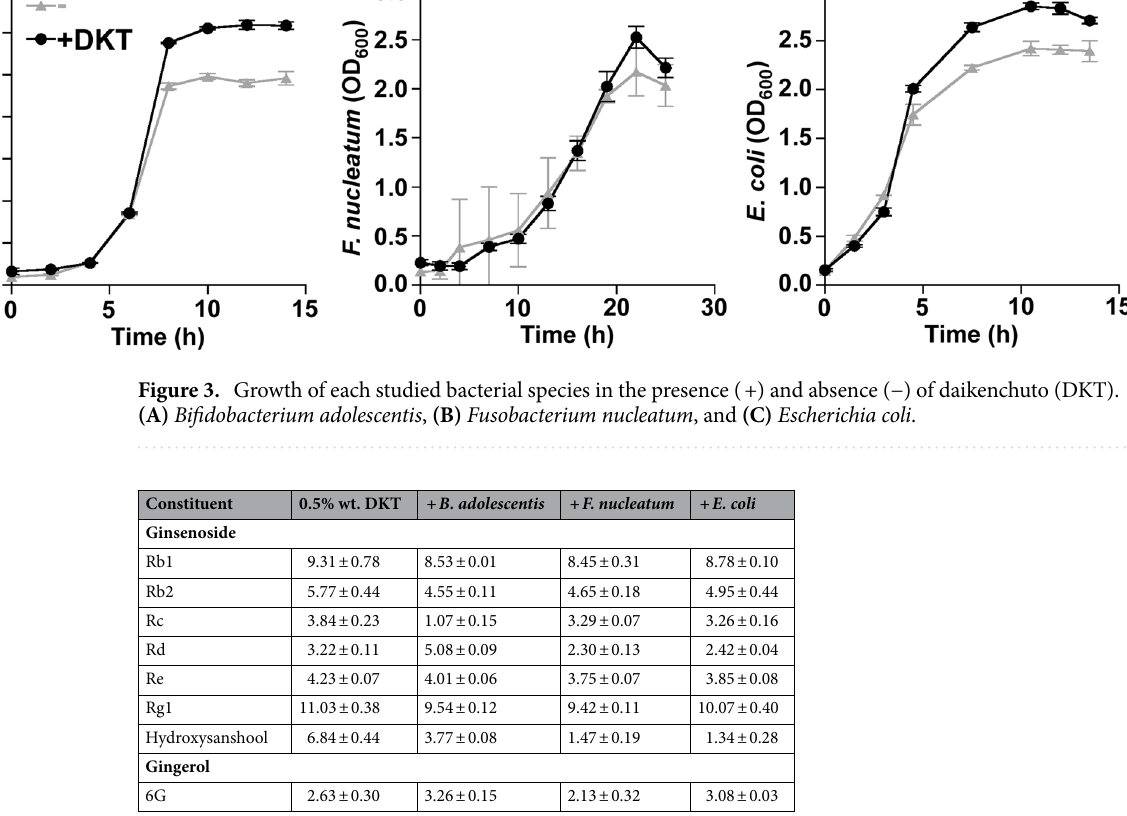
Table 2. Concentrations (μg/mL) of constituents of daikenchuto (DKT). Data are presented as mean ± SD. Concentrations are shown for 0.5% wt. DKT before cultivation and after cultivation with Bifidobacterium adolescentis , Fusobacterium nucleatum , or Escherichia